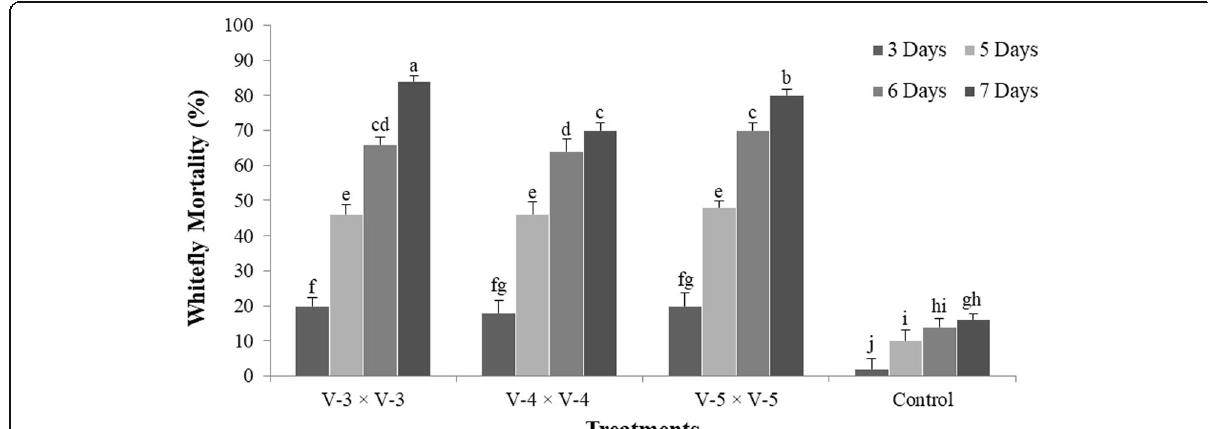
Fig. 3 Mean mortality (%) of Bemisia tabaci noted at different time intervals (3rd, 5th, 6th, and 7th) for bioassays executed with the binary combinations of different strains of Lecanicillium lecanii . Treatments included the combination of V-3 × V-3, V-4 × V-4, and V-5 × V-5, and control. The columns shows mean percent mortality ± SE ( n = 5). Treatment columns bearing different alphabets are significantly different from other treatments (LSD test at p = 0.05). See Table